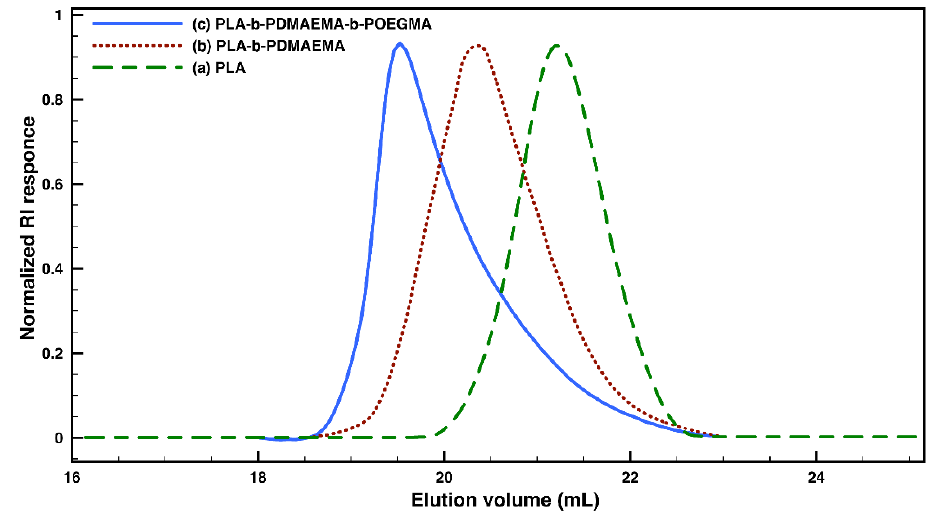
Figure 3. SEC elugrams of: ( a ) PLA-macroinitiator (M2, Ð = 1.15); ( b ) the corresponding amphiphilic PLA-b-PDMAEMA diblock copolymer (D2, Ð = 1.22); ( c ) amphiphilic PLA-b-PDMAEMA-b-POEGMA triblock copolymer (T2-3, Ð = 1.38) in tetrahydrofuran ( vs. narrow PS standards).